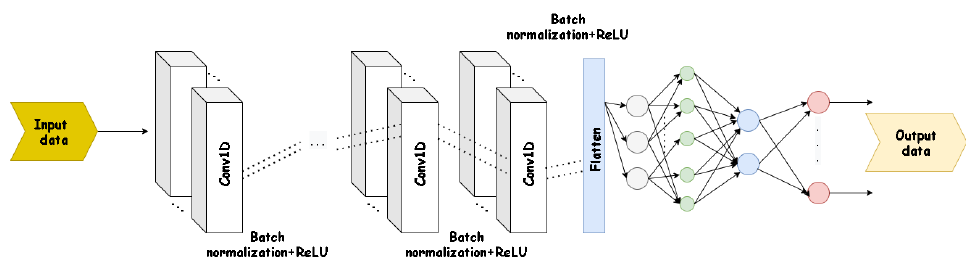
Figure 7. Classification model for SWaT